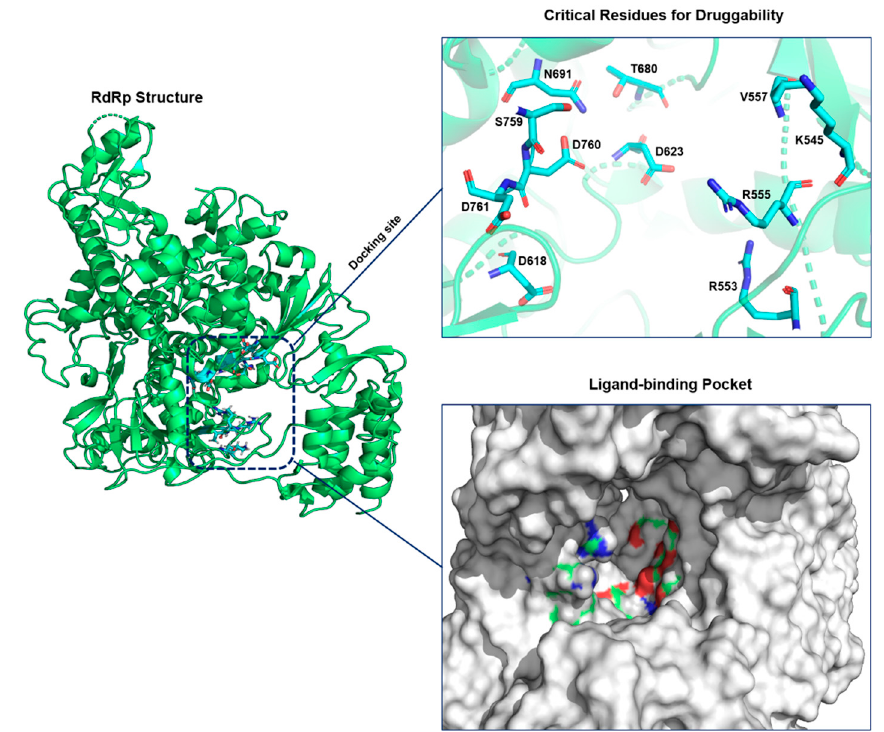
Figure 1. Structure of SARS-CoV-2 RNA-dependent RNA polymerase (RdRp) and its critical amino acid residues. On the right, a zoomed view of the active-site residues is shown in detail. RdRp is highlighted in green, and active-site binding residues are presented as cyan stick models.